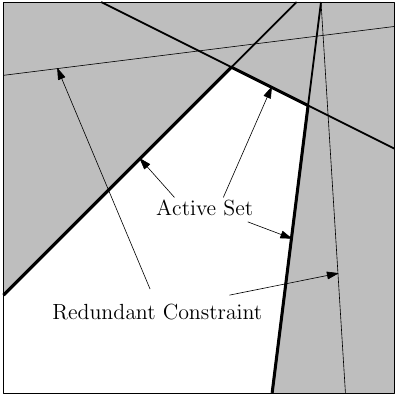
Figure 6. Example of redundant